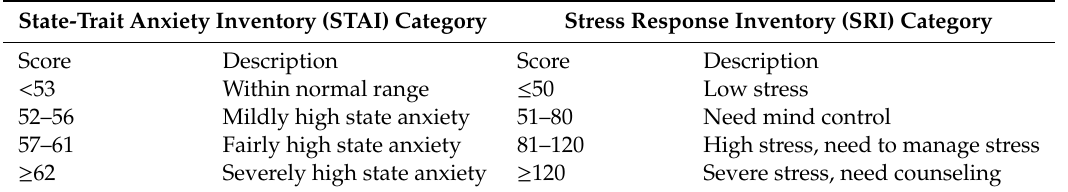
Table 1. Psychological Inventories Descriptors.